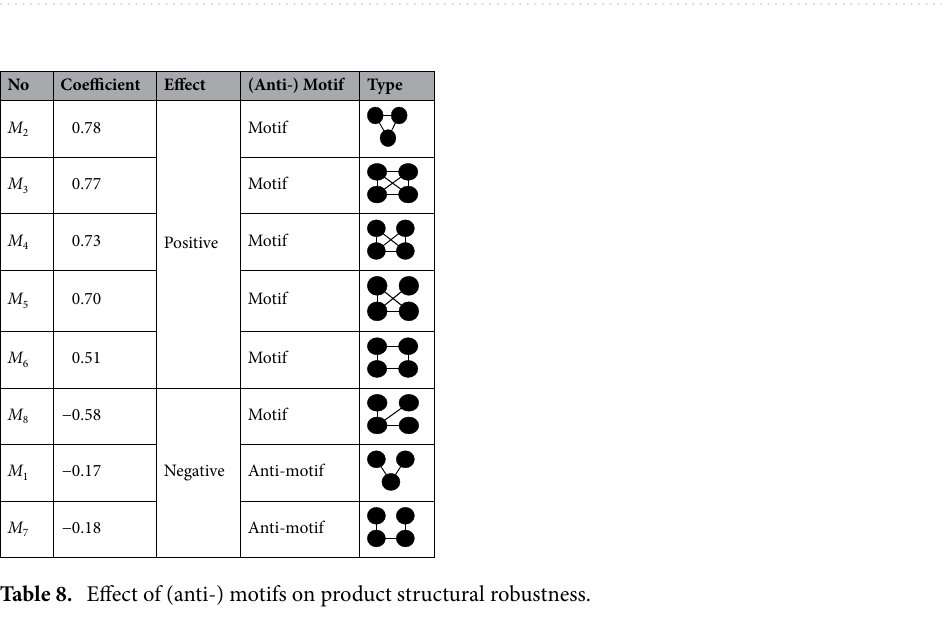
Table 7. Detailed parameters of the regression model.